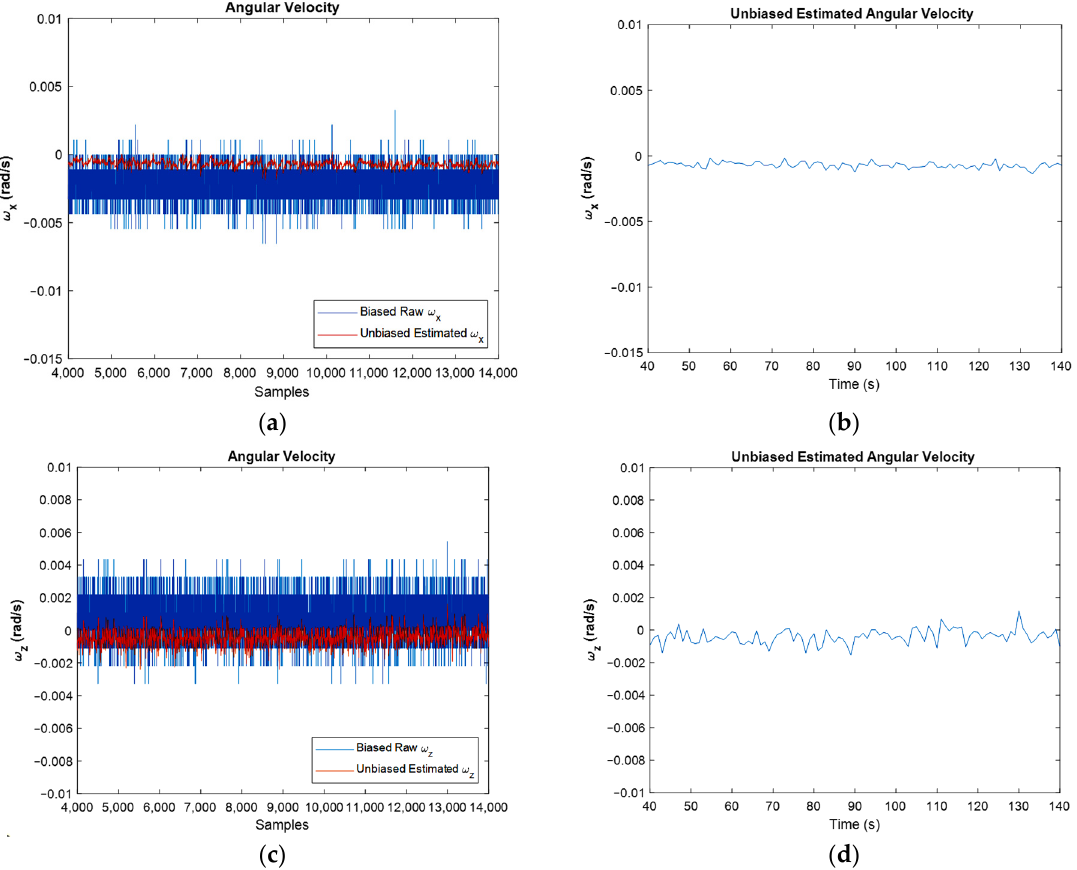
Figure 8. Biased raw angular velocity against estimated angular velocity for the whole samples ( a , c ), and for last amounts of estimation ( b , d ), in x and z directions, respectively.